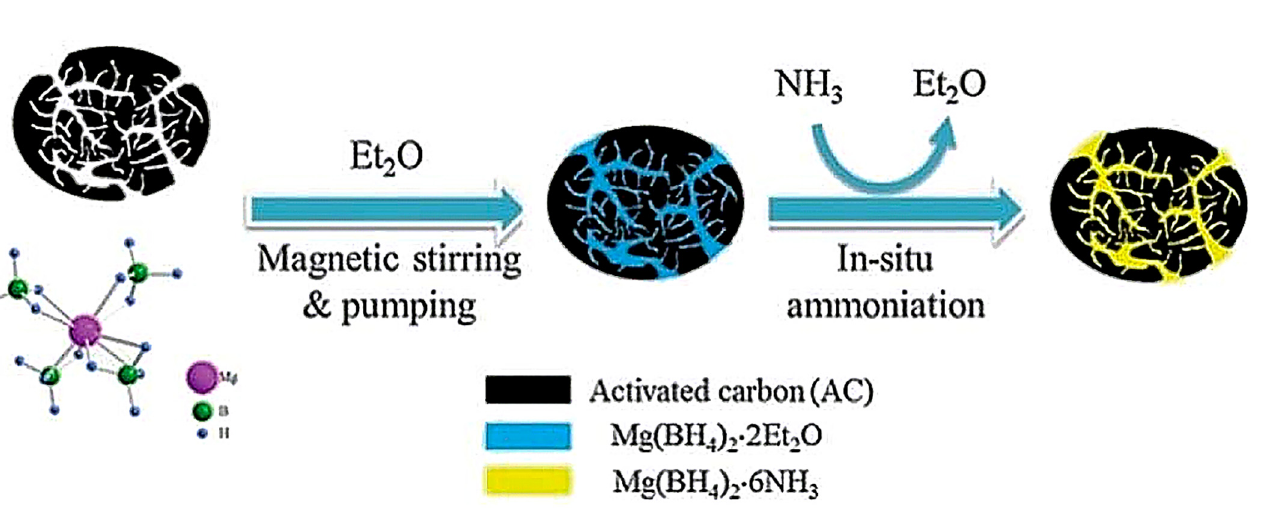
Figure 13. Volumetric release ( A ) and reaction extent ( B ) curves of the bulk Mg(BH 4 ) 2· 6NH 3 and Mg(BH 4 ) 2· 6NH 3 @AC nanocomposites. Figure is reprinted with permission from [256] .